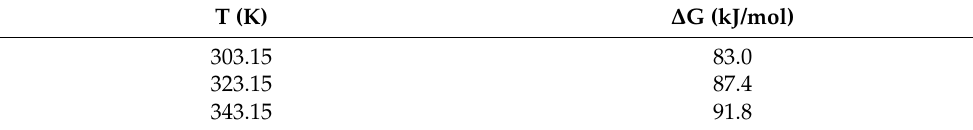
Table 6. Values of Gibbs energy change at different reaction temperature of this work.